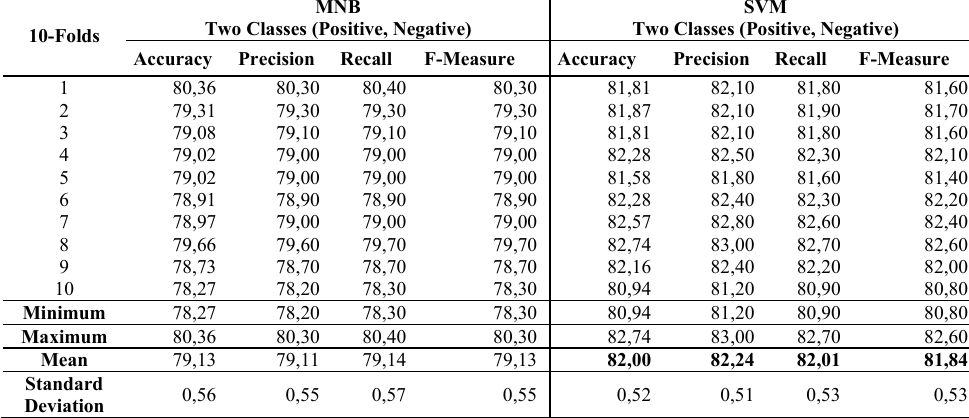
TABLE 5 C LASSIFICATION R ESULTS OF T HE G ENERAL A SPECT USING TWO